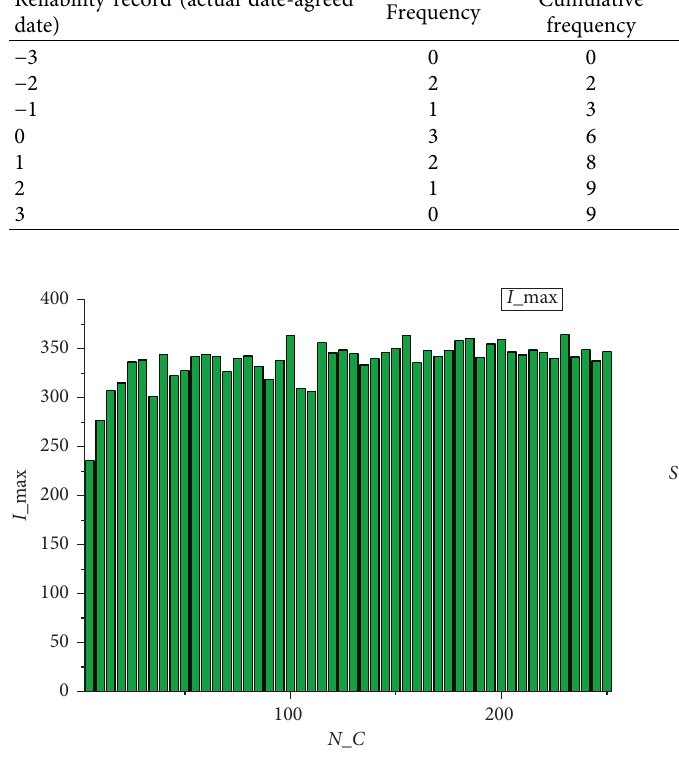
5: Sensitivity versus communication